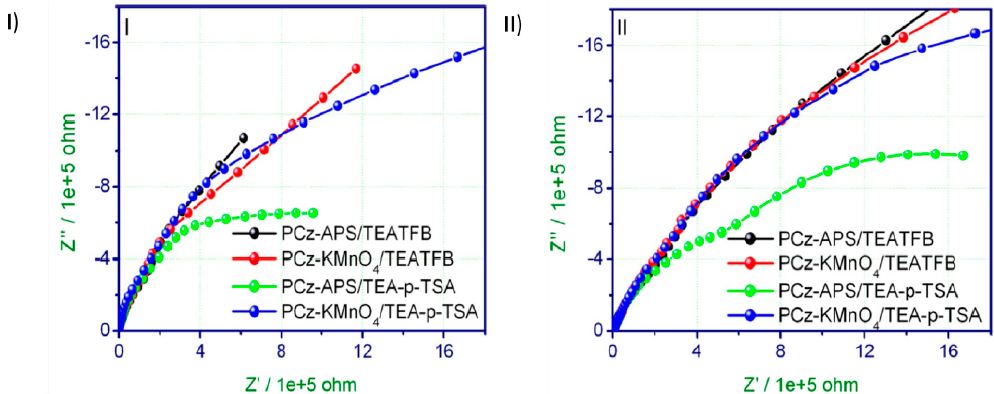
Figure 8. EIS responses, in form of Nyquist plots, for PCz–APS and PCz– KMnO 4 in the presence of 0.1 m TEATFB and 0.1 m TEA-p-TSA in acetonitrile at di ff erent electrodes: ( I ) GC and ( II ) Pt. Reprinted 0.1 m TEATFB and 0.1 m TEA-p-TSA in acetonitrile at different electrodes: ( I ) GC and ( II ) Pt. with permission from Kumar et al. [106]. Copyright (2015) Reprinted with permission from Kumar et al. [106]. Copyright (2015) Wiley.